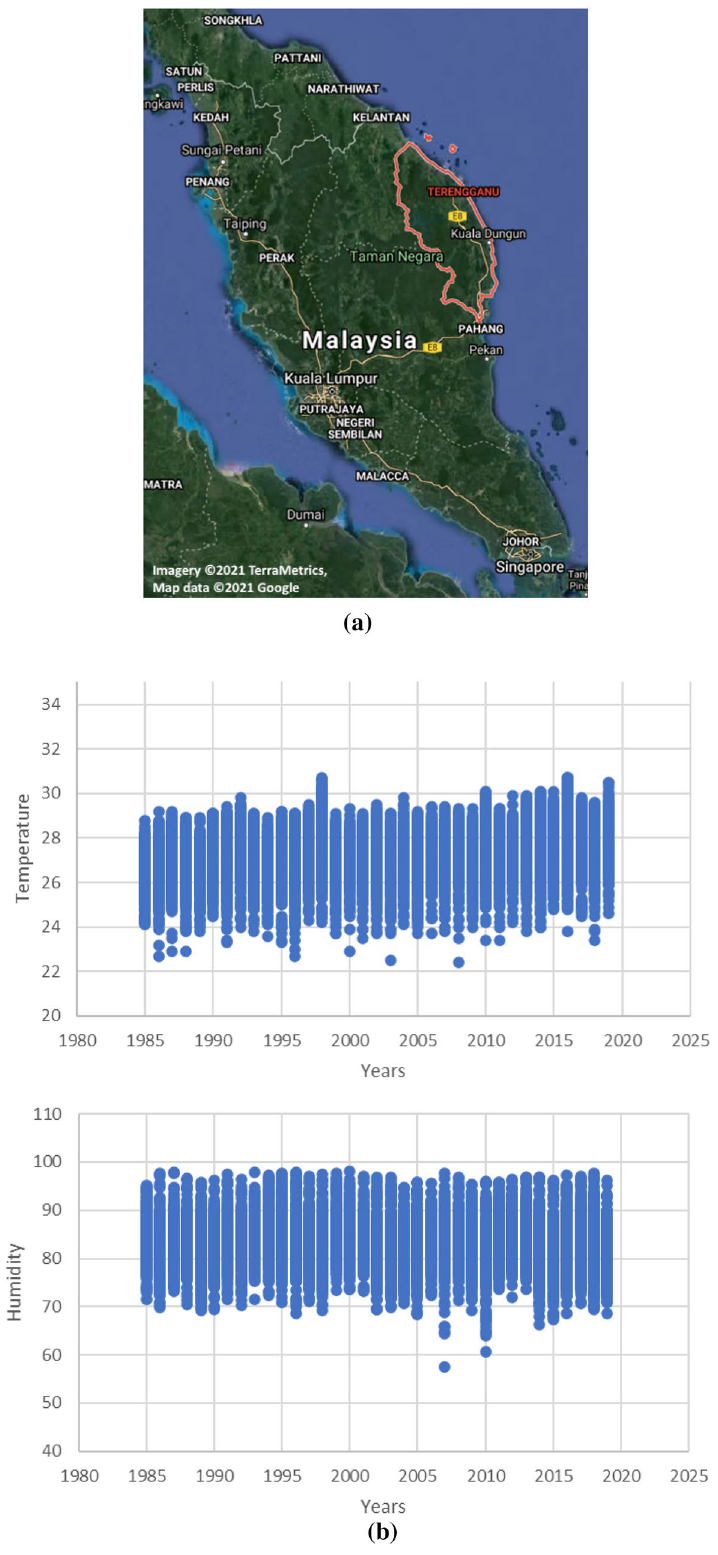
Figure 1. ( a ) Location of Kuala Terengganu on the map [Imagery ©2021 TerraMetrics, Map data ©2021 Google], ( b ) Temperature and humidity